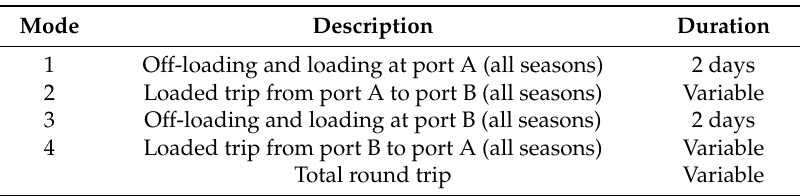
Table 20. Time schedule of the ship.